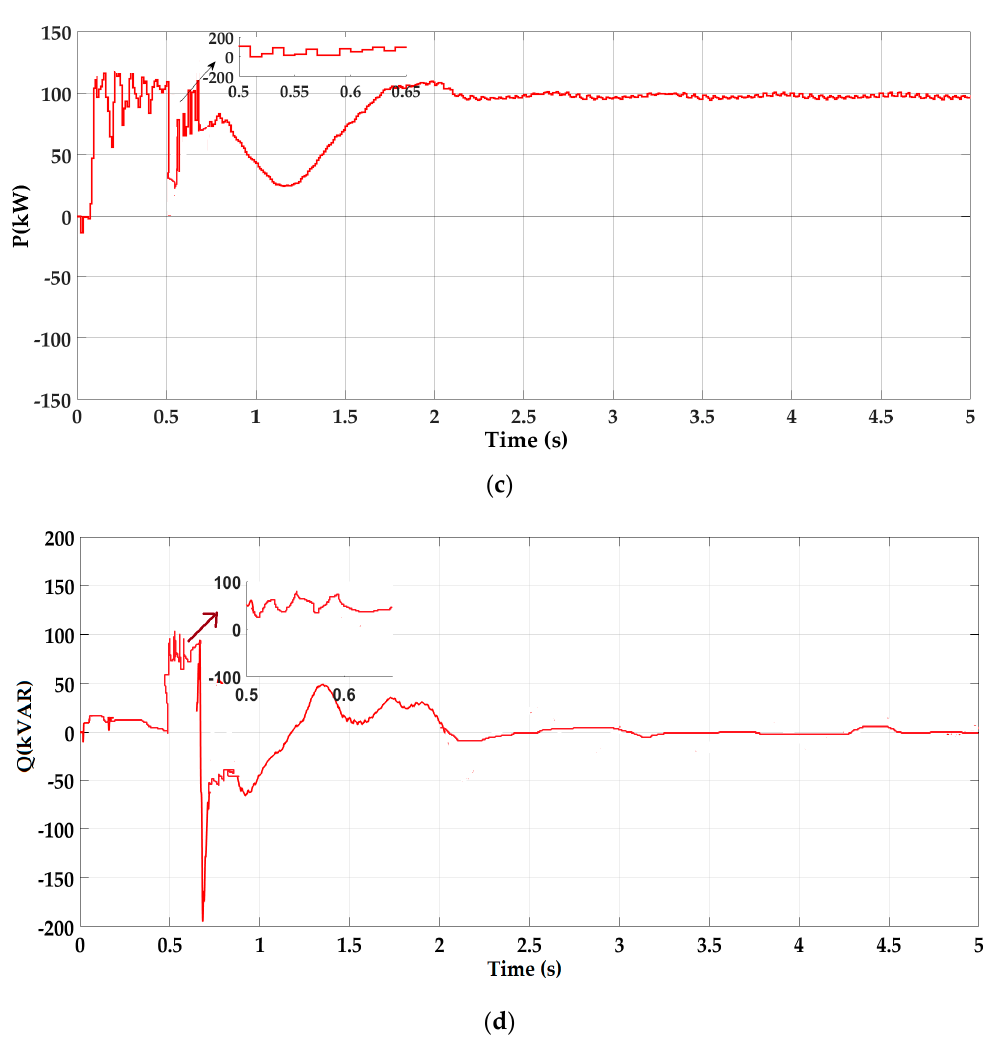
Figure 9. Simulation results of MPPT control under a symmetrical (3LG) fault. ( a ) Grid voltage (Vgrid), ( b ) DC-link voltage (DCL), ( c ) active power (P), ( d ) reactive power (Q).